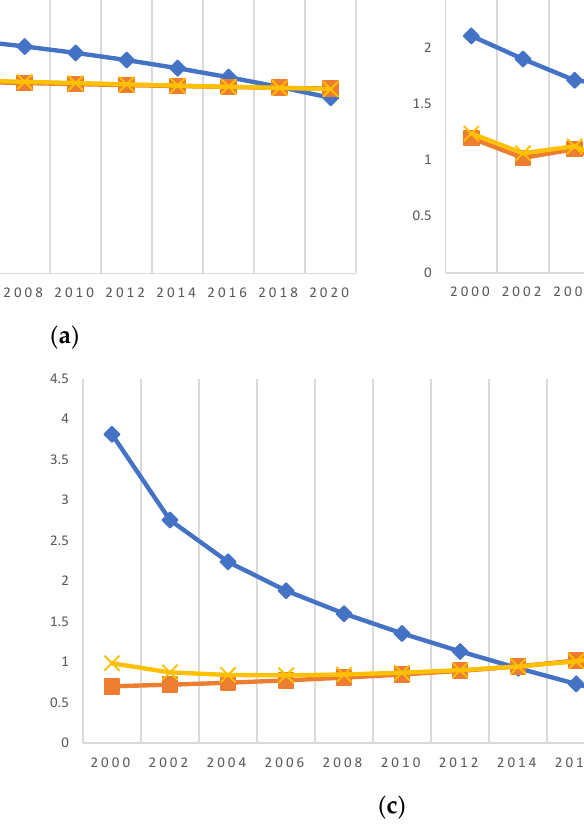
Figure 3. Visualization of energy efficiency energy indicators σ -convergence assessment. Note: ( a ) by primary energy consumption; ( b ) by the share of renewable energy in final consumption; ( c ) by the coefficient of dependence of energy imports on solid fossil fuels; blue line — Ukraine, orange line — EU countries, yellow line — Ukraine and EU countries.